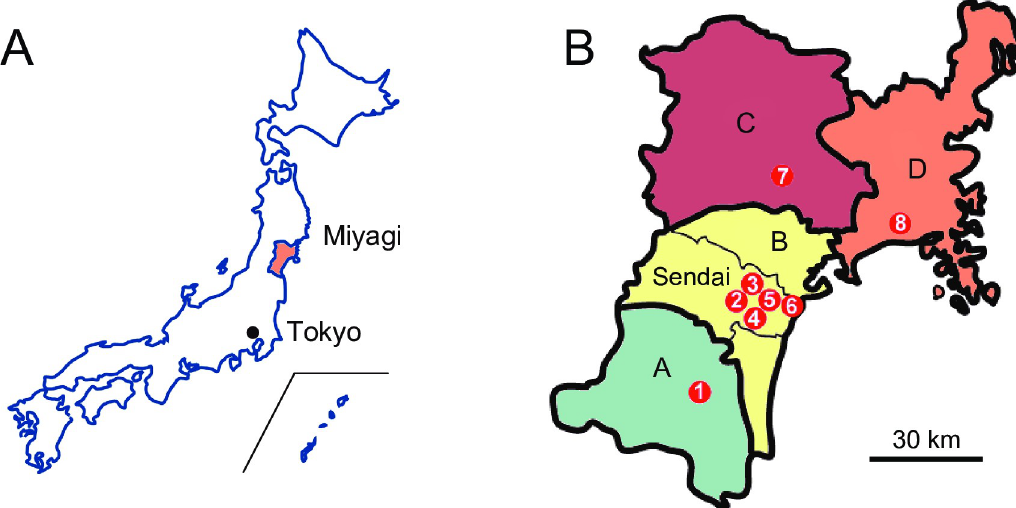
Fig 1. Localization of participating hospitals in Miyagi prefecture, Japan. A: a map of Japan. B: a map of Miyagi Prefecture. (1) South Miyagi Medical Center, (2) Tohoku University Hospital, (3) Tohoku Rosai Hospital, (4) Sendai City Hospital, (5)